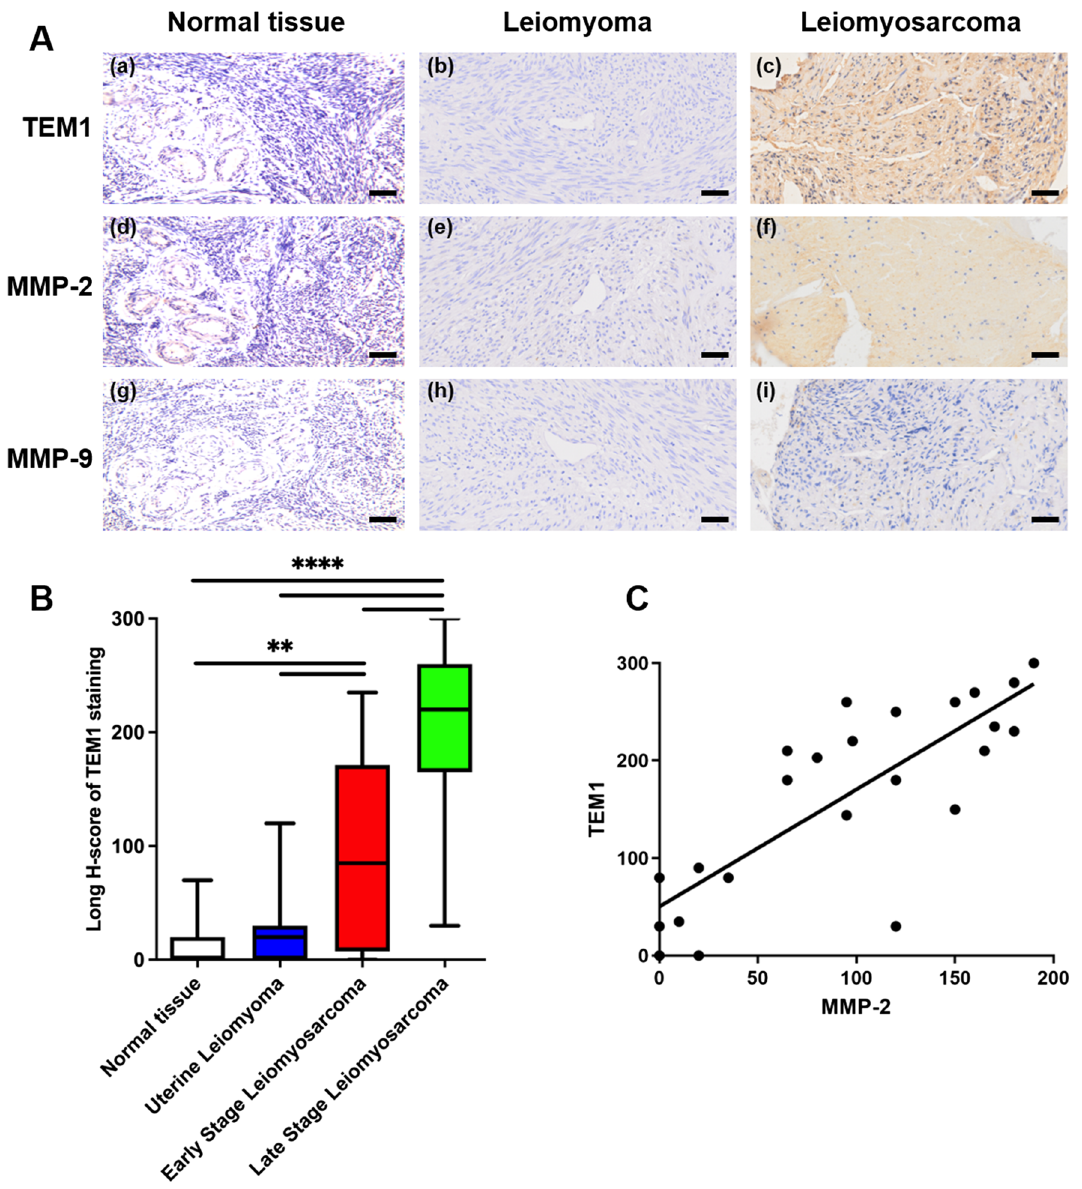
Fig. 1 The expression of TEM1, MMP-2 and MMP-9 in different uterine samples. A Representative immunohistochemical results of TEM1, MMP-2 and MMP-9 staining. TEM1 and MMP-2 were negative in uterine myometrium (normal tissue) and leiomyoma, strong positive in leiomyosarcoma; MMP-9 staining was negative or weakly expressed in all samples. Scale bar, 50 μm. B Boxplot for Long H-scores of TEM1 in normal myometrium, leiomyoma and leiomyosarcoma tissues. TEM1 Long H-scores were positively correlated with tumor stages, r = 0.9554. **, P < 0.01; ****, P < 0.0001. C TEM1 expression was positively correlated with MMP-2 expression in uterine leiomyosarcoma tissues. Correla- tion curves are shown with r square, and P ‐ values from Pearson´s correlation analysis. R square = 0.6487, Pearson r = 0.8054, P <